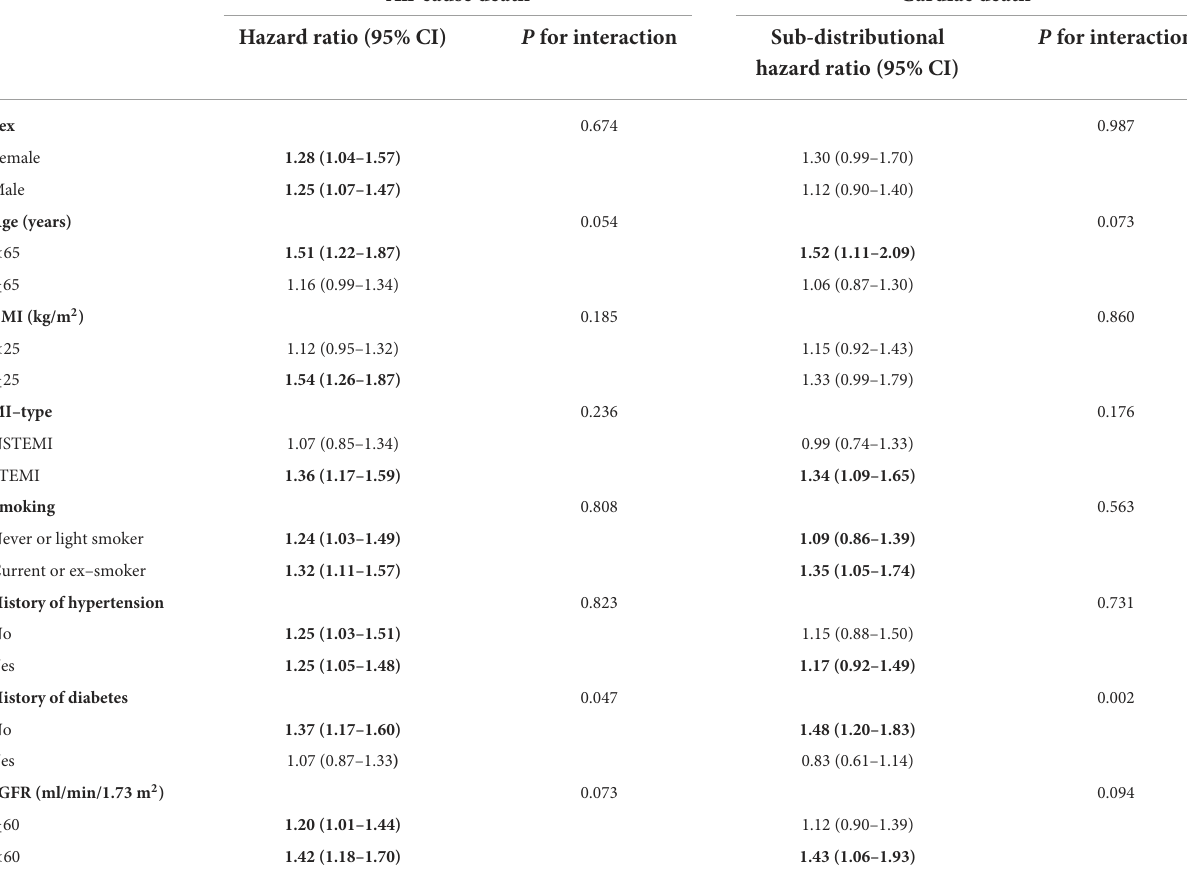
TABLE 8 Stratified analysis of all-cause death and cardiac death for corrected